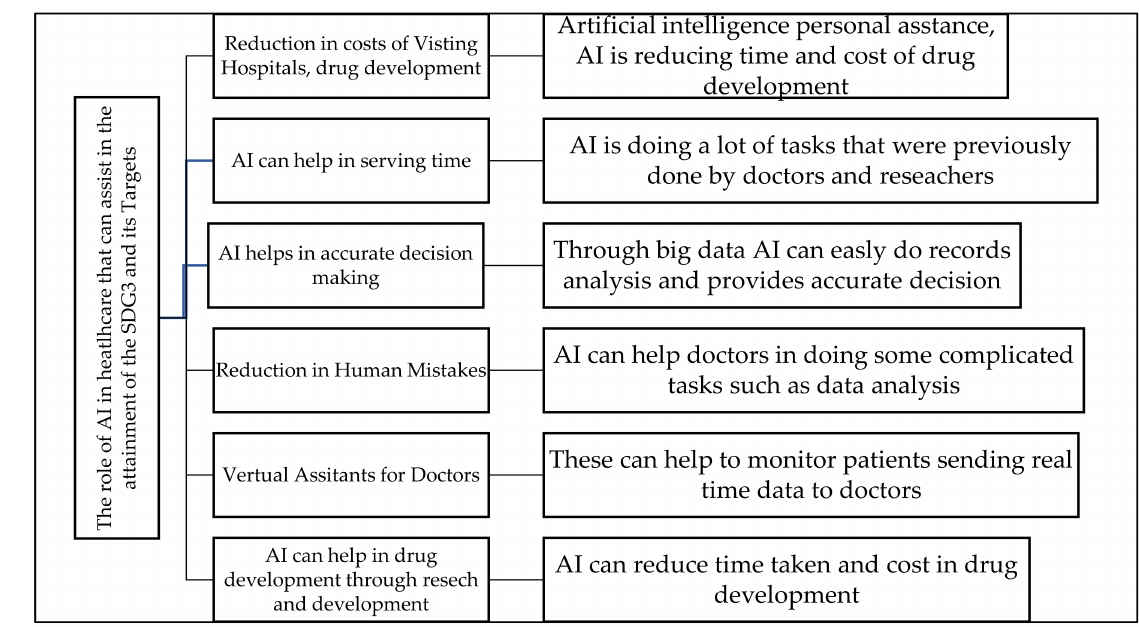
Figure 4. The roles of AI: the role of AI in healthcare can assist in the attainment of SDG3 and its targets in the Post-COVID World. Source Author’s Analysis.